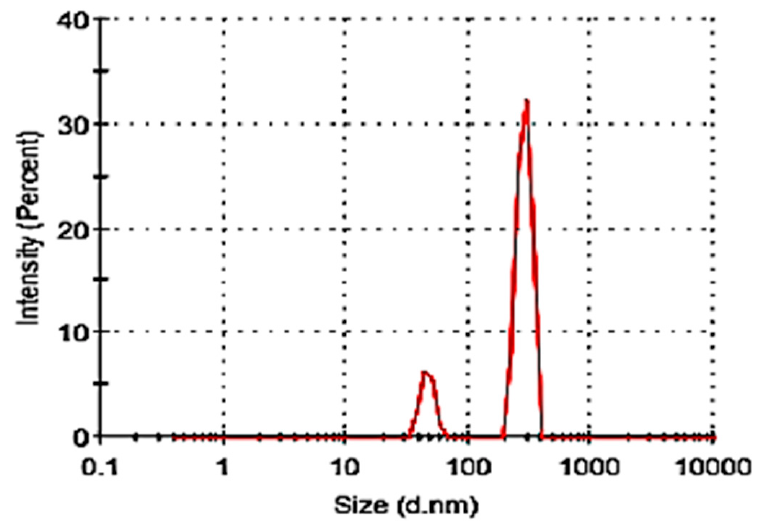
Figure 2. Particle size distribution of silk film powder.